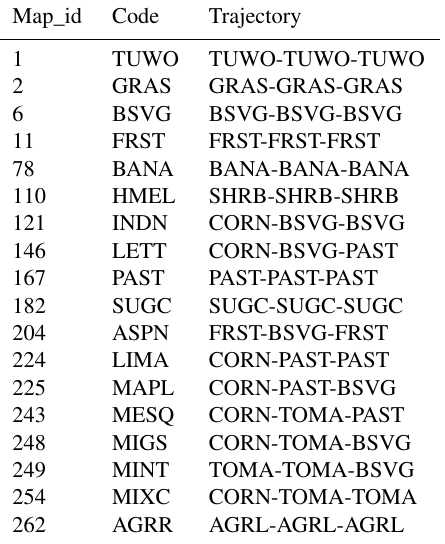
Table B2. Dynamic agricultural land use trajectory and their crop or vegetation cover meaning.